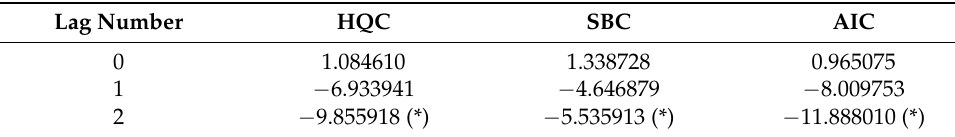
Table 4. The results of the optimal lag for estimating the model.